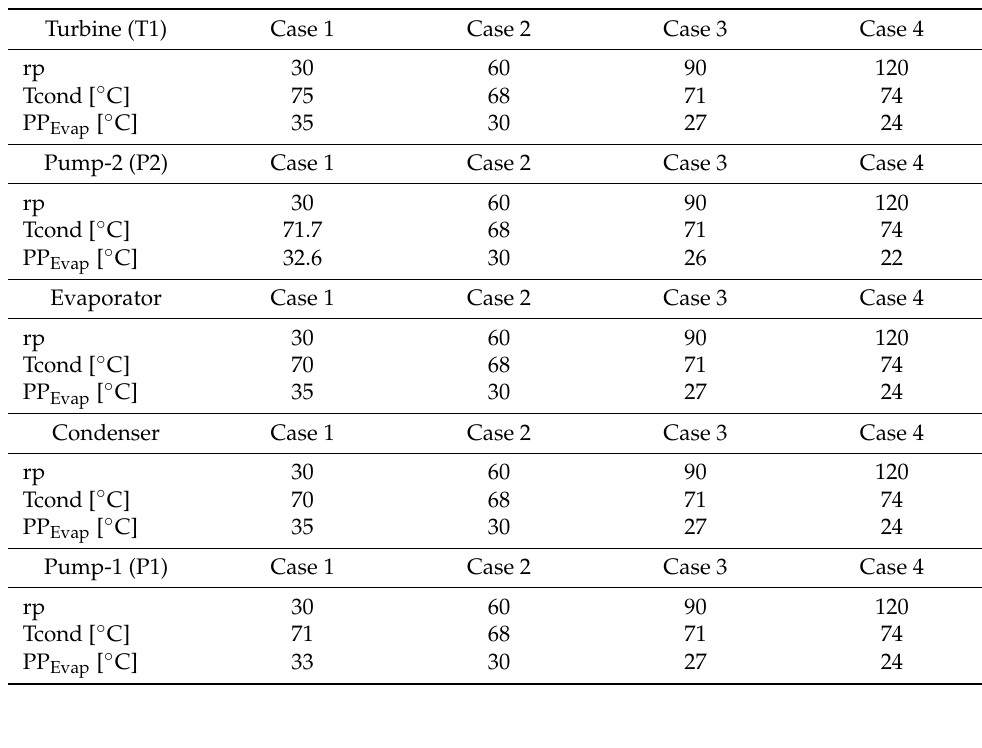
Table 9. Changes to the parameters chosen for each component.